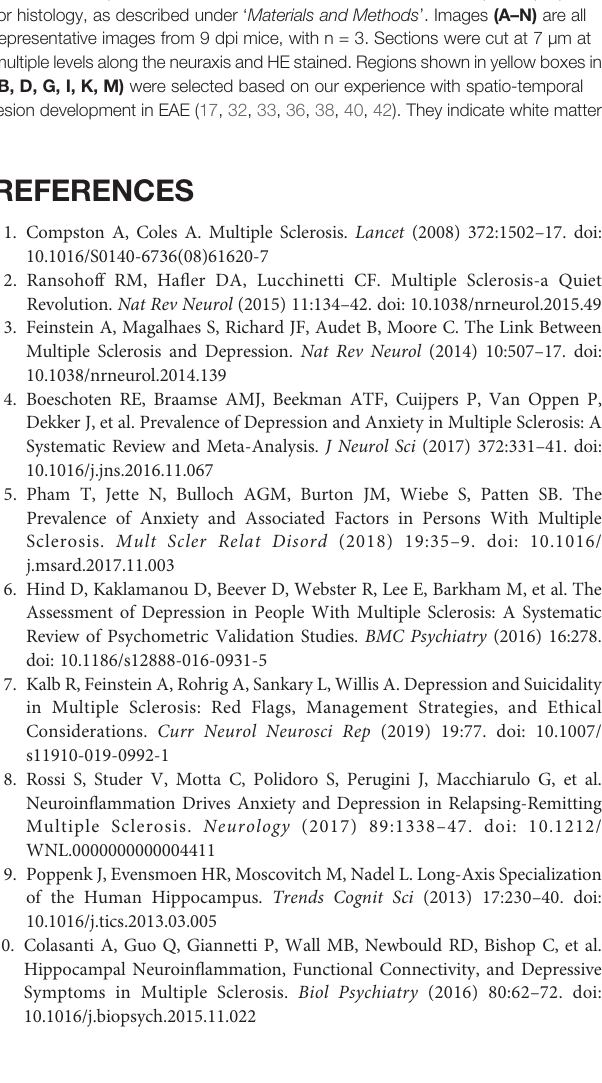
Supplementary Figure 6 | Effect of EAE induction on S1PR expression in the hippocampus. Experimental conditions and primers for qPCR analysis of S1PR1 S1PR2, S1PR3, S1PR4 and S1PR5 are described in the Materials and Methods section( Table 1 ).Expression ofS1PR1, S1PR3,andS1PR5, was detectedin EAE- induced (orange) mice, but was negative for S1PR2 and S1PR4 following normalization against sham mice; hence analysis of only S1PR1, S1PR3, and S1PR5 at the protein level. FTY720 treatment was associated with signi fi cantly reduced levels of S1PR1, S1PR3, and S1PR5 expression at both dosages relative to the EAE group. Experiments were replicated 3 times, n = 4 mice/group. Data were analyzed using a two-tailed Student ’ s t-test and shown as mean ± standard error of the mean